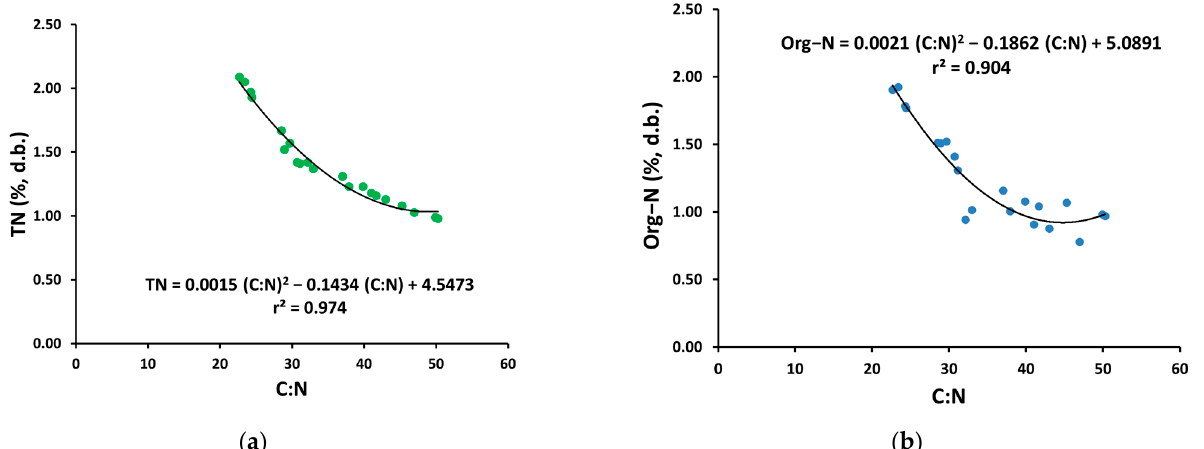
Figure 1. Variation in total and organic nitrogen content with respect to C:N of equine manure: ( a ) Total nitrogen (TN); ( b ) organic nitrogen (Org − N).